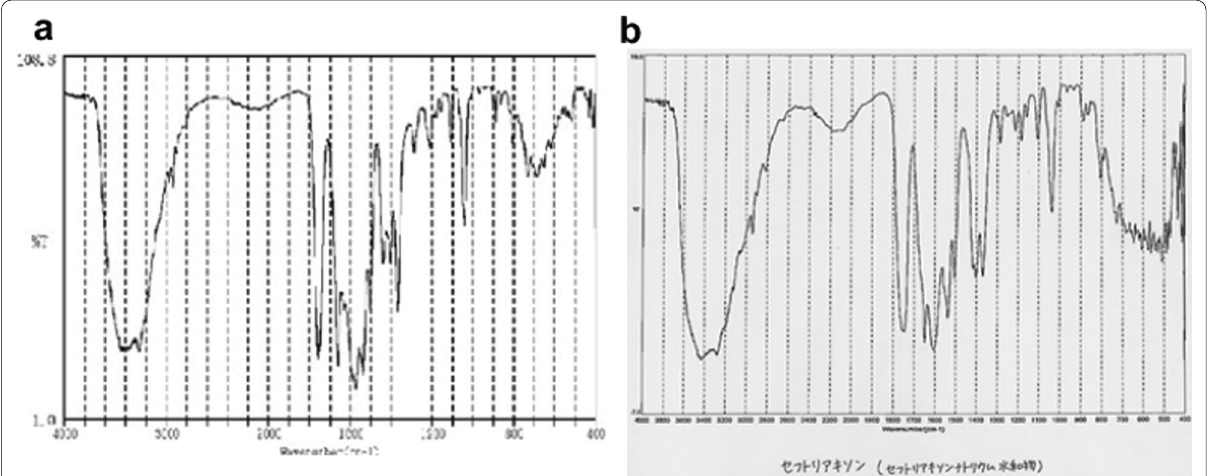
Fig. 4 Comparative analysis of gallstones and ceftriaxone powder using infrared spectroscopy. Gallstones ( a ) and ceftriaxone powder ( b ) show very similar patterns of infrared